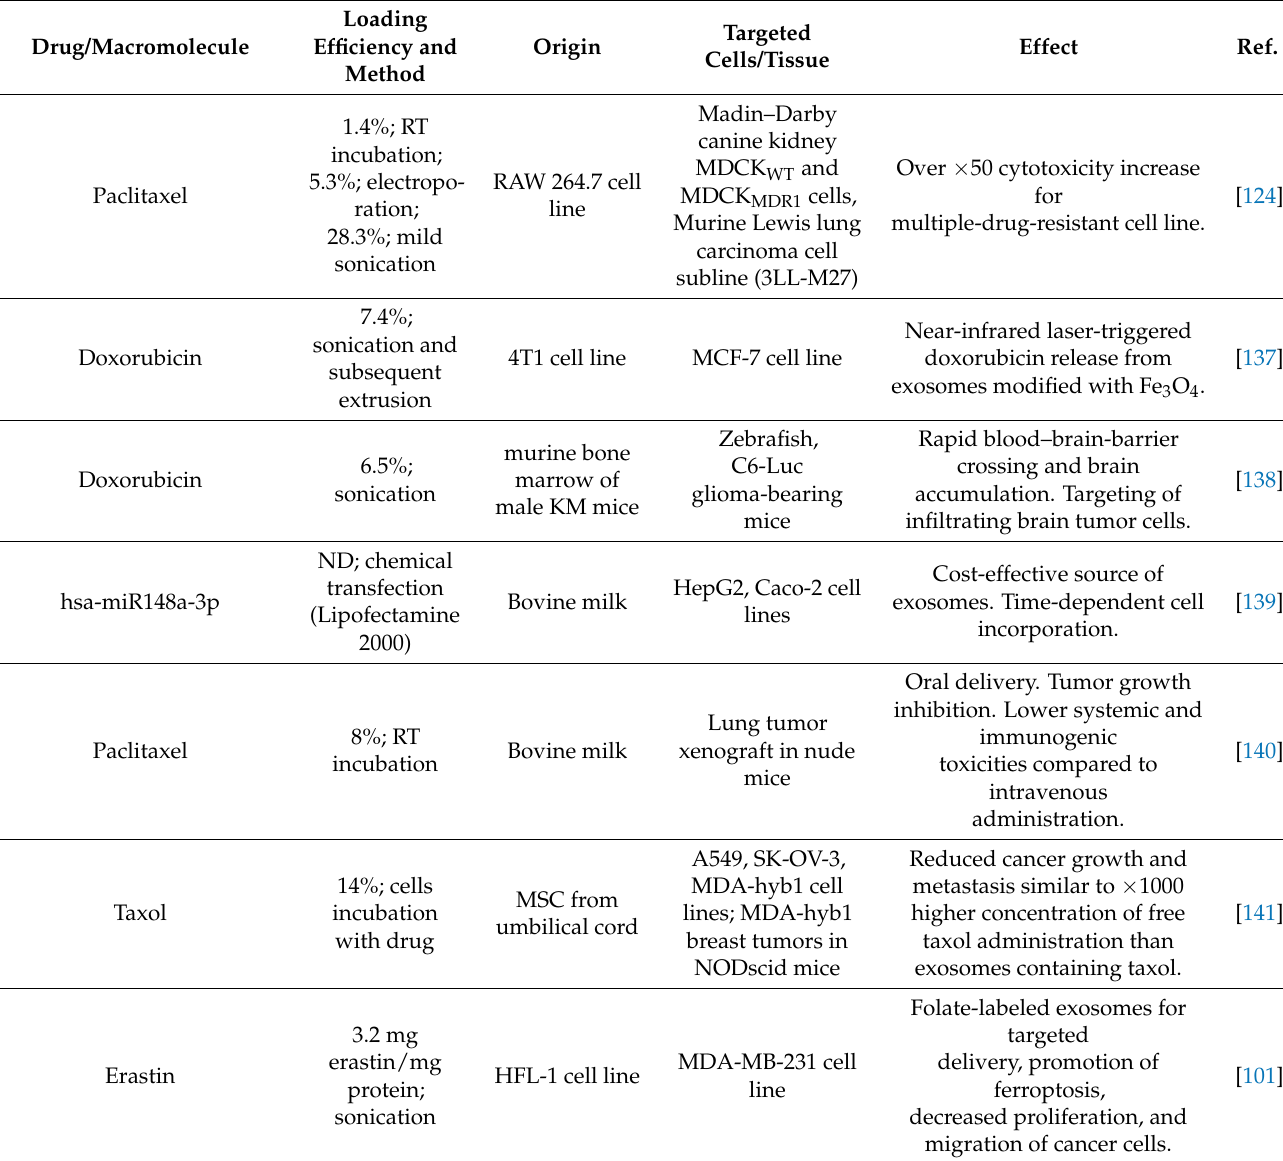
Table 4. Examples of drugs, macromolecules, and potential targeted therapy strategies with